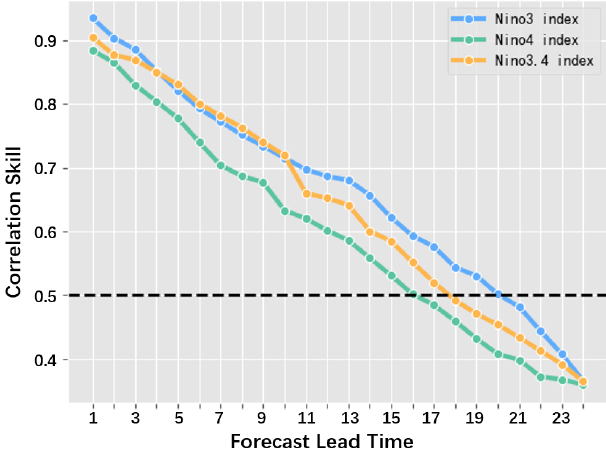
Figure 14. The correlation skills between the forecast results of the ENSO-ASC and real-world observations on three Niño indexes with the forecast lead time increasing over the validation